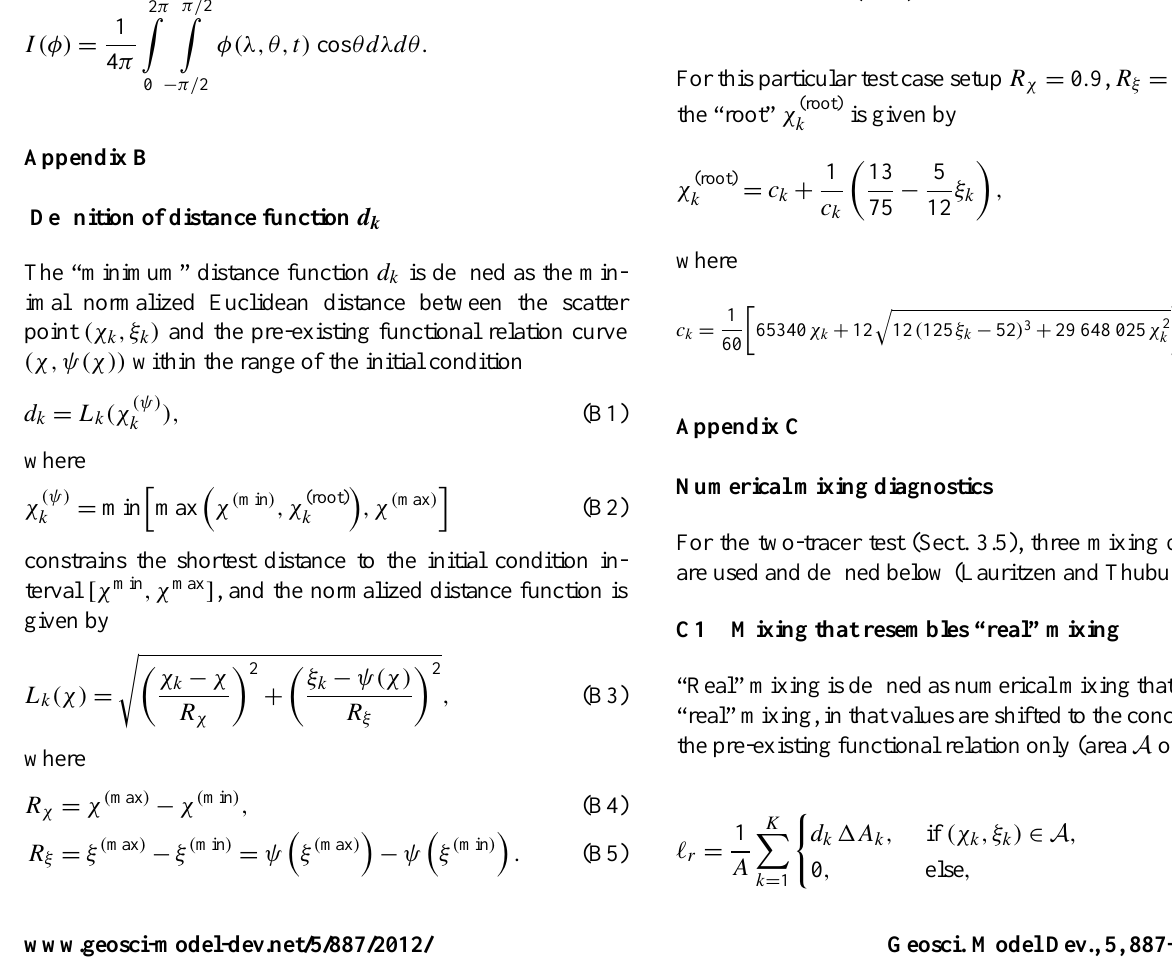
Fig. C1. A schematic of the classification of numerical mixing. If a scatter point is located in the area labeled with A (mathematically defined in Eq. C2), it is categorized as “real” mixing . Similarly, for the area labeled with B (defined in Eq. C4), it is categorized as range-preserving unmixing . The remaining part of the domain is referred to as overshooting . The thick solid line is the pre-existing non-linear functional relation curve. See text or Lauritzen and Thuburn (2012) for details.